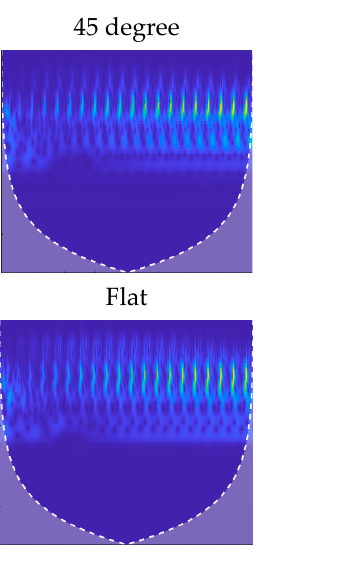
Figure 8. CWT scalograms of the solid test specimens.